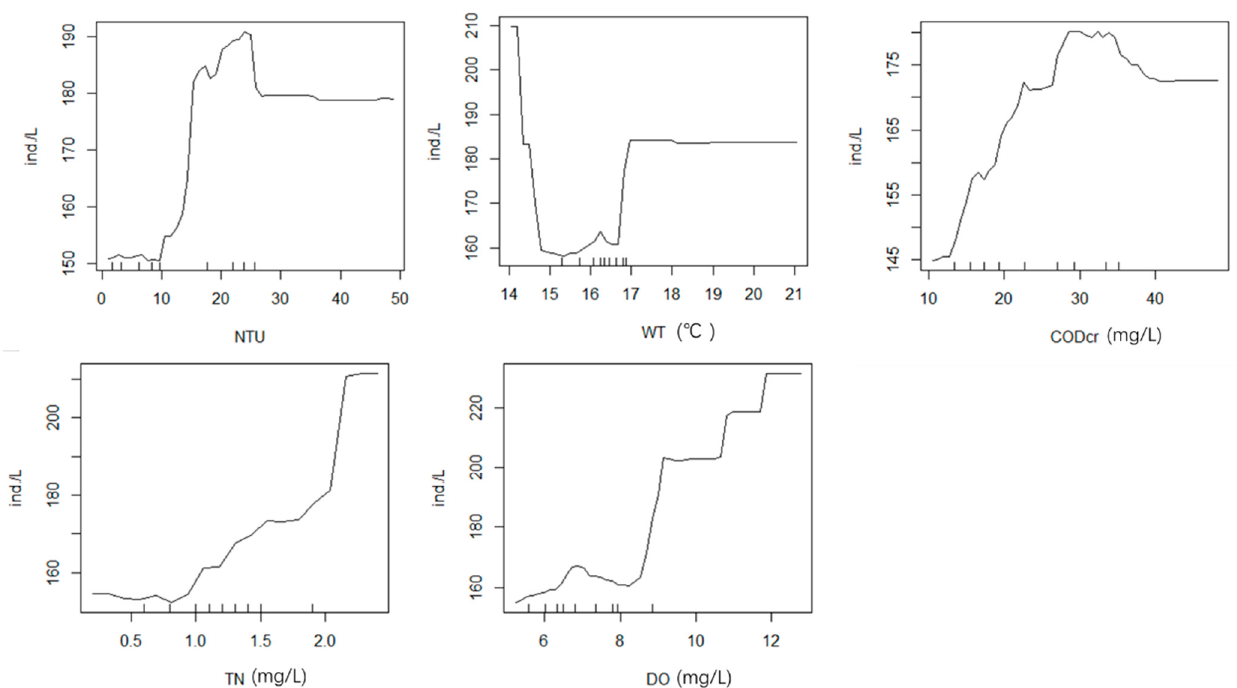
Figure 6. Environmental factors ranked in descending order of importance based on ( a ) %IncMSE and ( b ) major environmental drivers of phytoplankton abundance in spring.